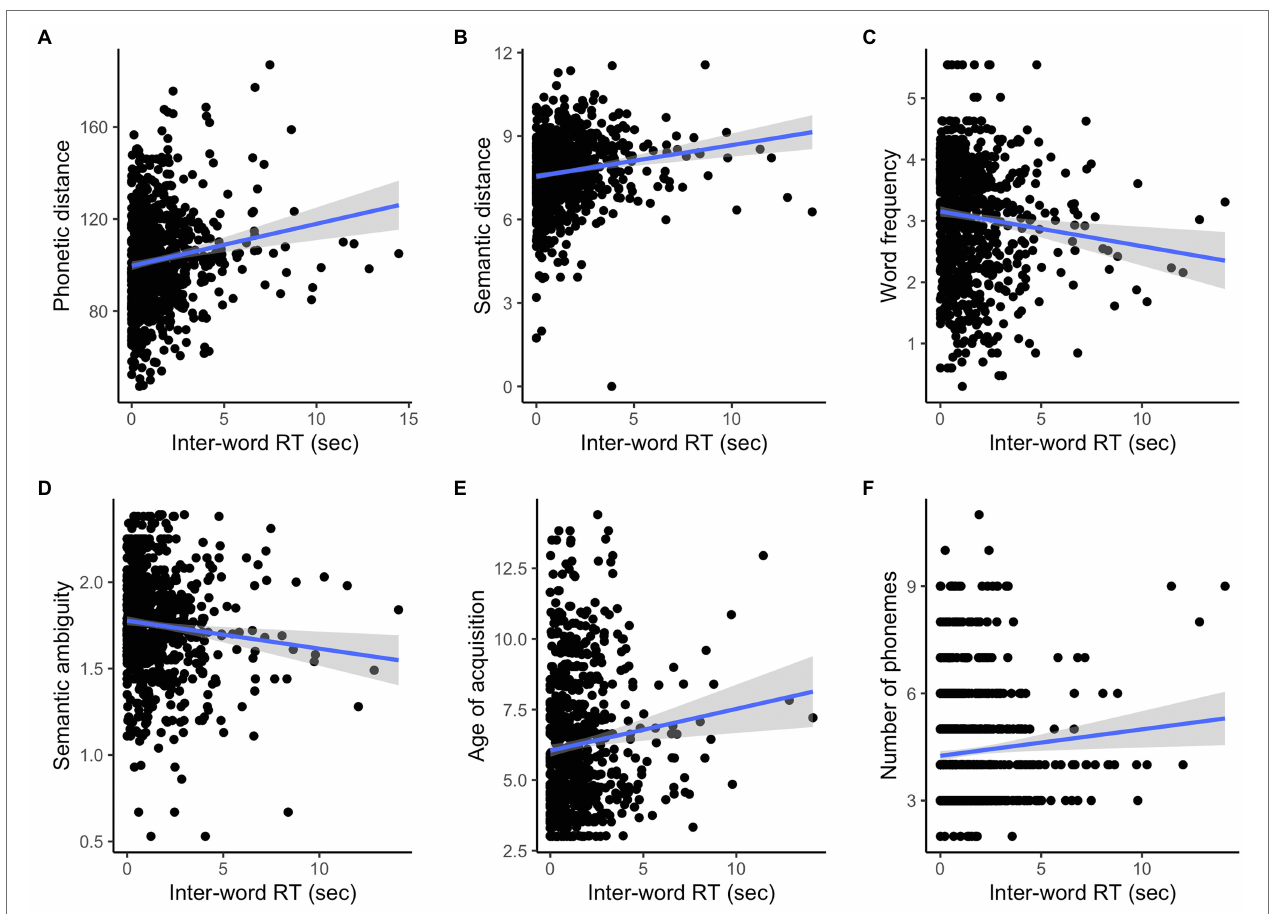
FIGURE 6 | Inter-word RT and the language measures.